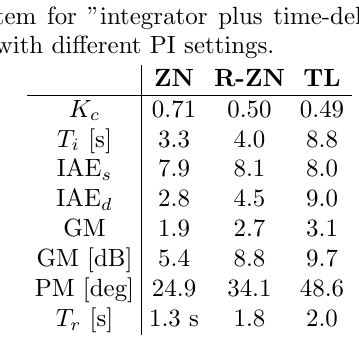
Table 2: Controller settings and performance and ro- bustness measures for simulated control sys- tem for ”integrator plus time-delay” process with different PI